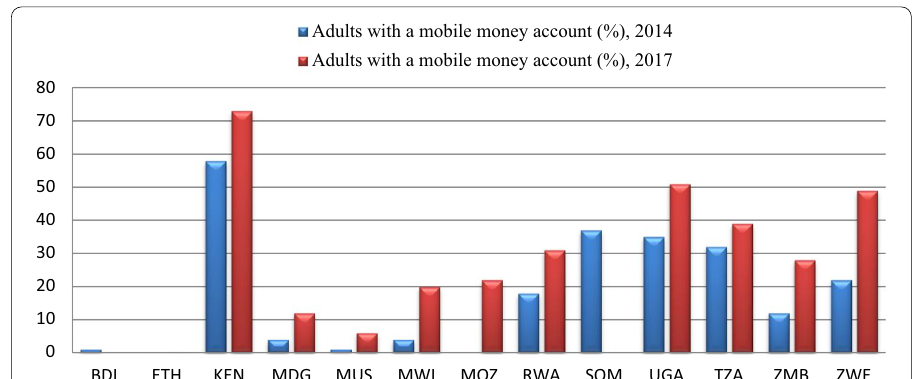
Fig. 2 Mobile money account penetration rates in East African countries. This chart shows the disparity between East African countries ( Burundi Ethiopia, Kenya, Madagascar, Malawi, Mauritius, Mozambique, Rwanda, Somalia, Tanzania, Uganda, Zambia and Zimbabwe ) in terms of access to mobile money accounts during the years 2014 and 2017. Note : The representation is made by the author using data from the 2017 Global Findex Database. Countries like Comoros, Djibouti, Eritrea, Reunion, Seychelles and Somaliland are not included in this chart because the 2014 and 2017 Global Findex databases provide no data about them. Furthermore, while no data are available for Burundi and Somalia for the year 2017, no data are available for Mozambique for the year